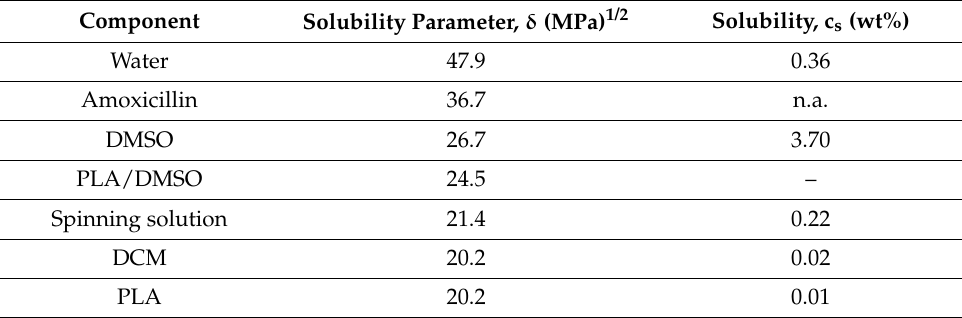
Table 2. Interactions and solubility of Amox in the various components.